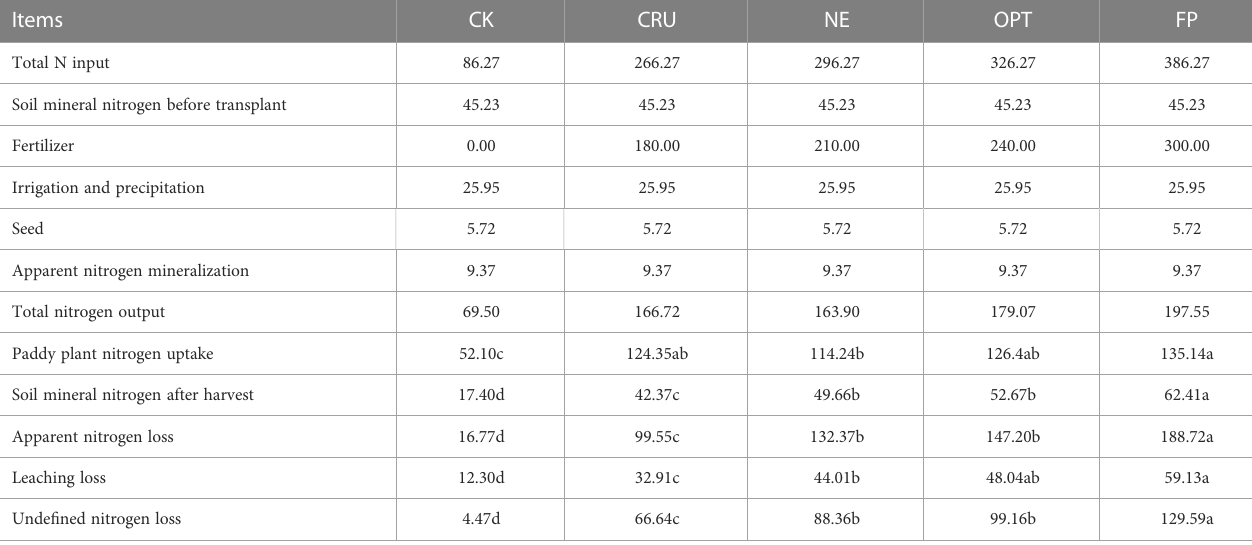
TABLE 5 Nitrogen balance in 0-100 cm depth soil pro fi le under different nitrogen fertilizer treatments during the paddy growth period (unit: kg hm -2 ).